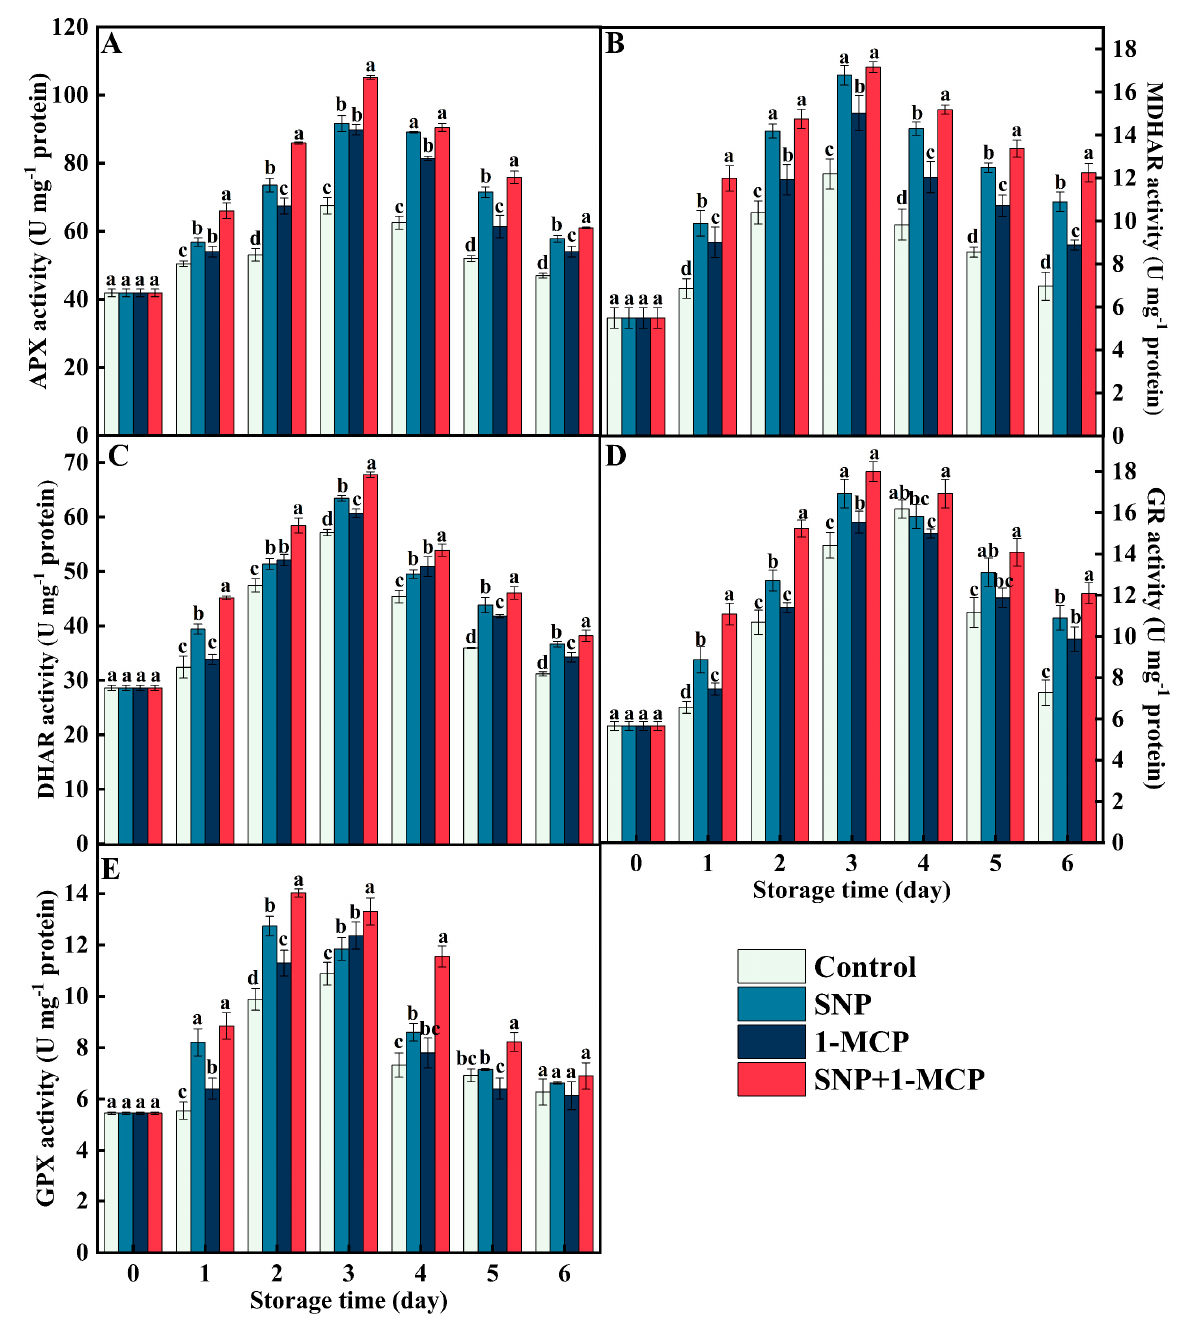
Figure 4. ( A ) Ascorbate peroxidase (APX), ( B ) monodehydroascorbate reductase (MDHAR), ( C ) dehydroascorbate reductase (DHAR), ( D ) glutathione reductase (GR), and ( E ) glutathione peroxidase (GPX) activities of Agaricus bisporus at 25 °C. The letters indicate the significant difference ( p < 0.05), and the bars indicate standard error (means ± SE).